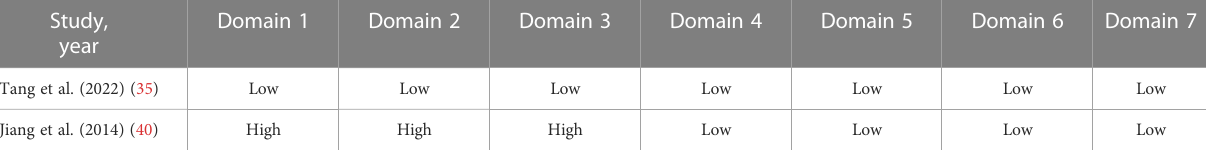
TABLE 2 Bias risks of the included